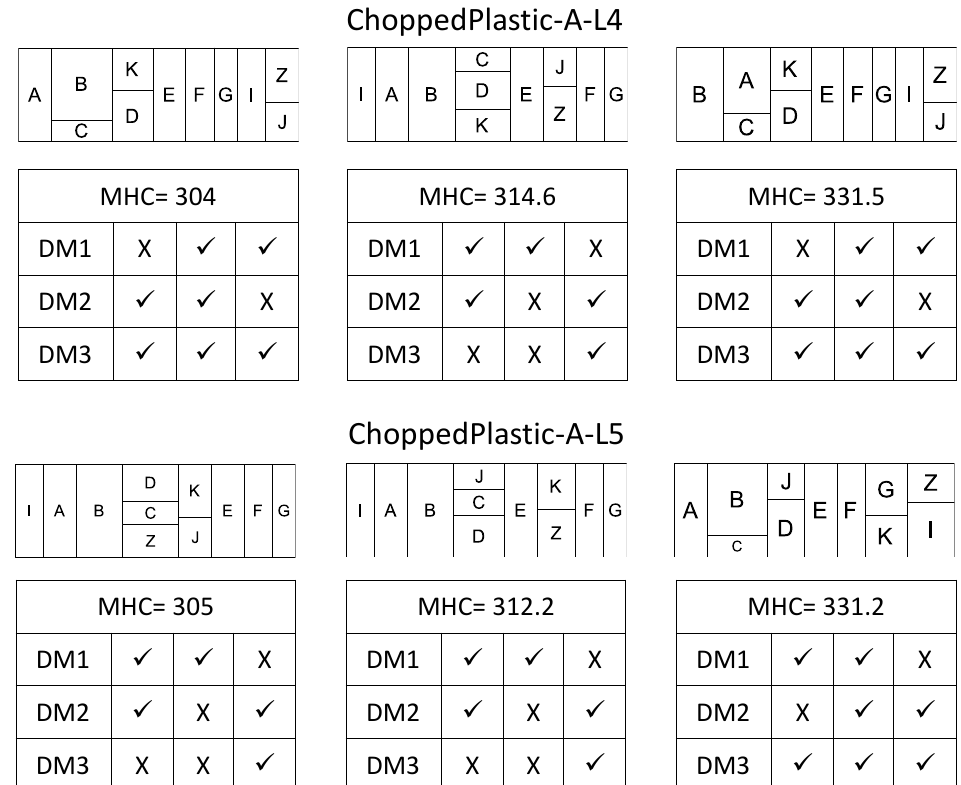
Figure 16. Best solutions found in Alternative launch 4 to 5 of ChoppedPlastic